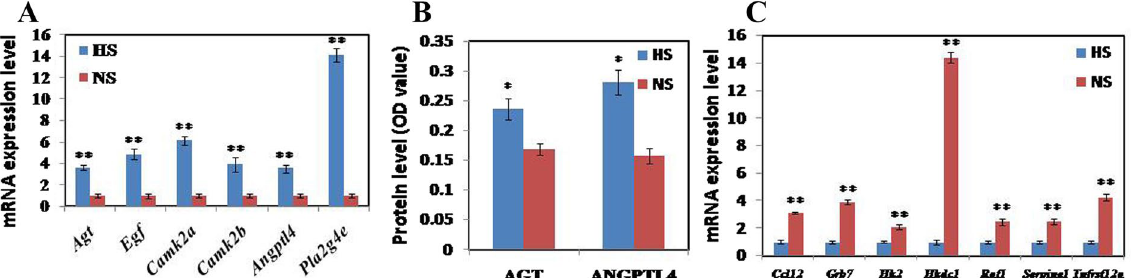
Figure 9. Changes in the mRNA and protein levels of genes involved in RAS signaling in adipose tissue from feeding a HS diet. ( A ) Transcript abundance of genes, which are jointly involved in RAS and lipid metabolism, were up-regulated. ( B ) The protein contents of AGT and ANGPTL4 in abdominal fat (AF) were increased. ( C ) Transcript abundance of genes, which are jointly involved in RAS and lipid metabolism, were down-regulated.